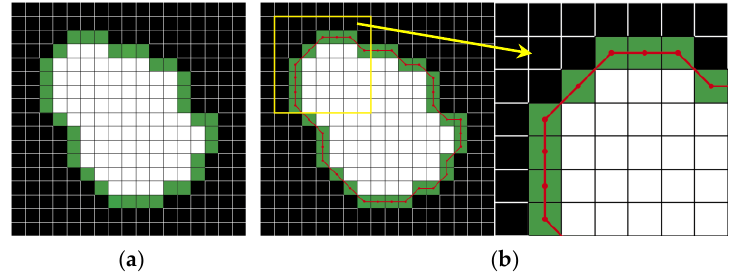
Figure 7. Border of an object: ( a ) border pixels of the object; and, ( b ) border line of the object.